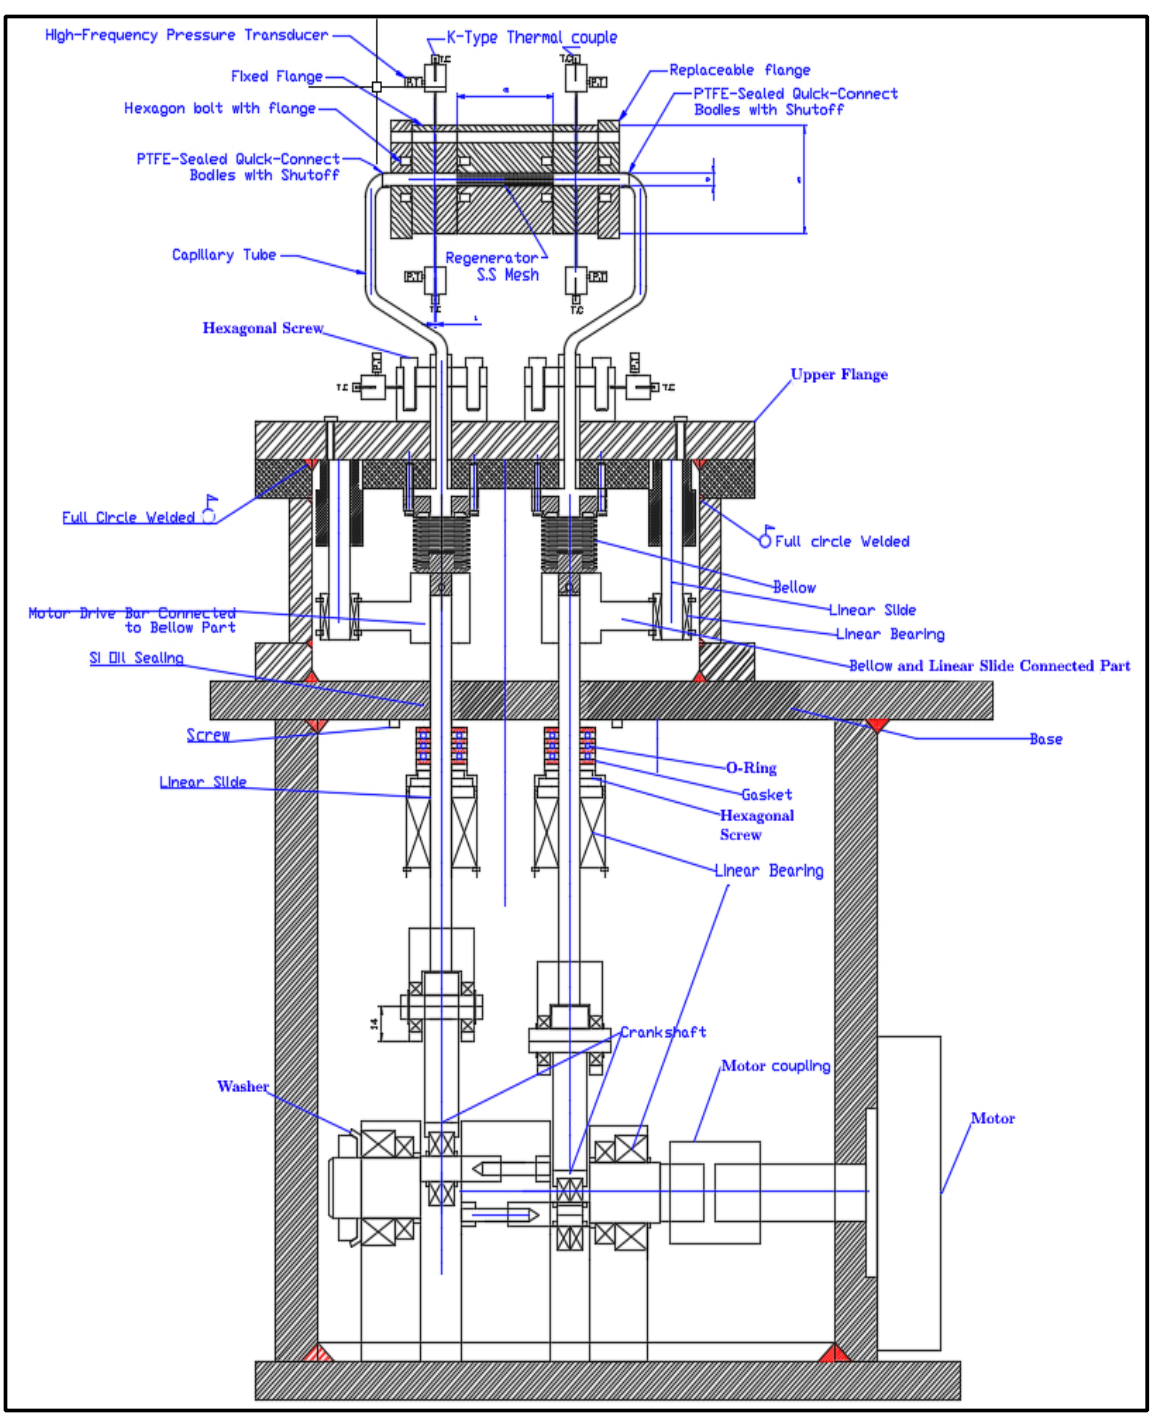
Figure 1. Experimental test